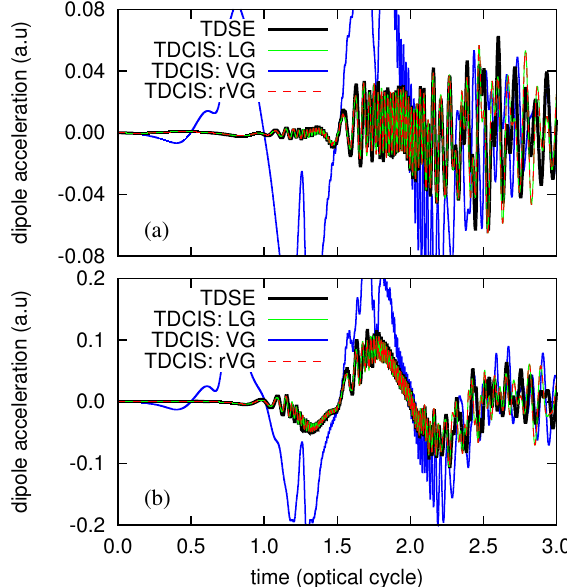
Figure 3. Time evolution of the dipole acceleration of 1D-He exposed to a laser pulse with a wavelength of 750 nm and an intensity of ( a ) 5 × 10 14 W/cm 2 and ( b ) 1 × 10 15 W/cm 2 . Comparison of the results with TDCIS in the LG, VG, and rVG with that of TDSE.